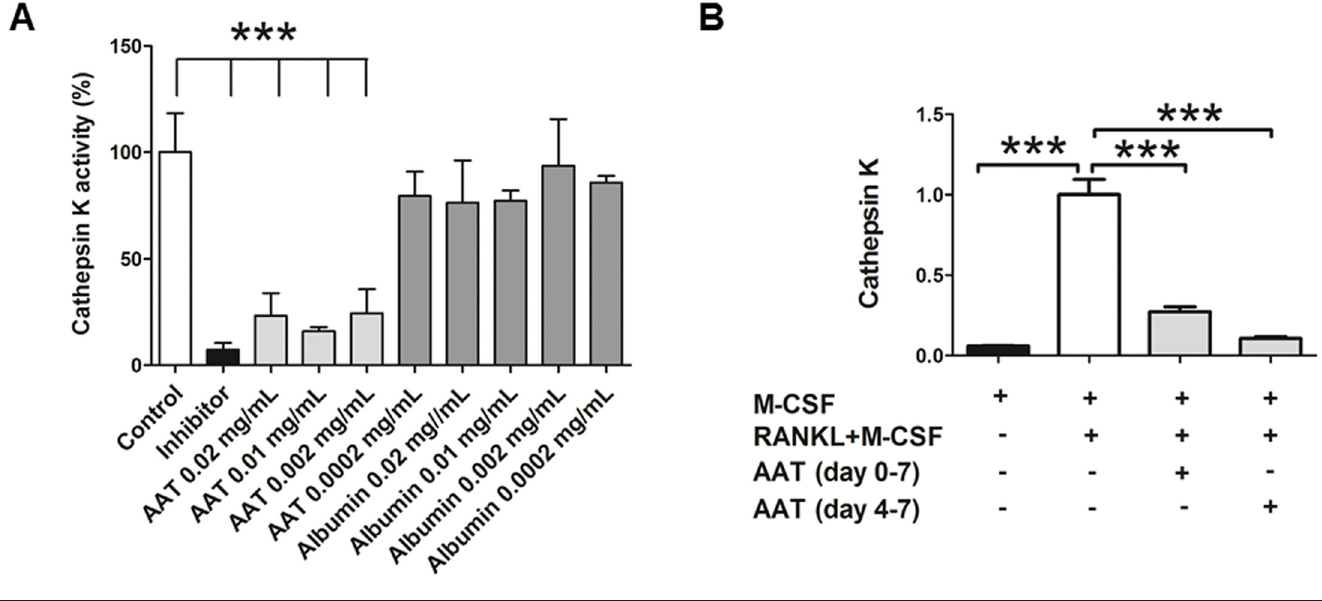
Figure 7. AAT inhibits CatK activity and gene expression. (A) Percentage of inhibition of CatK activity by AAT determined by CatK drug discovery kit. (B) Effect of AAT treatment (2 mg/mL) on CatK gene expression (fold changes of CatK mRNA expression) was determined by qPCR. Values are means ± SEM of at least triplicate samples. Data were analyzed using one-way analysis of variance followed by Dunnett’s multiple comparison test. *** P